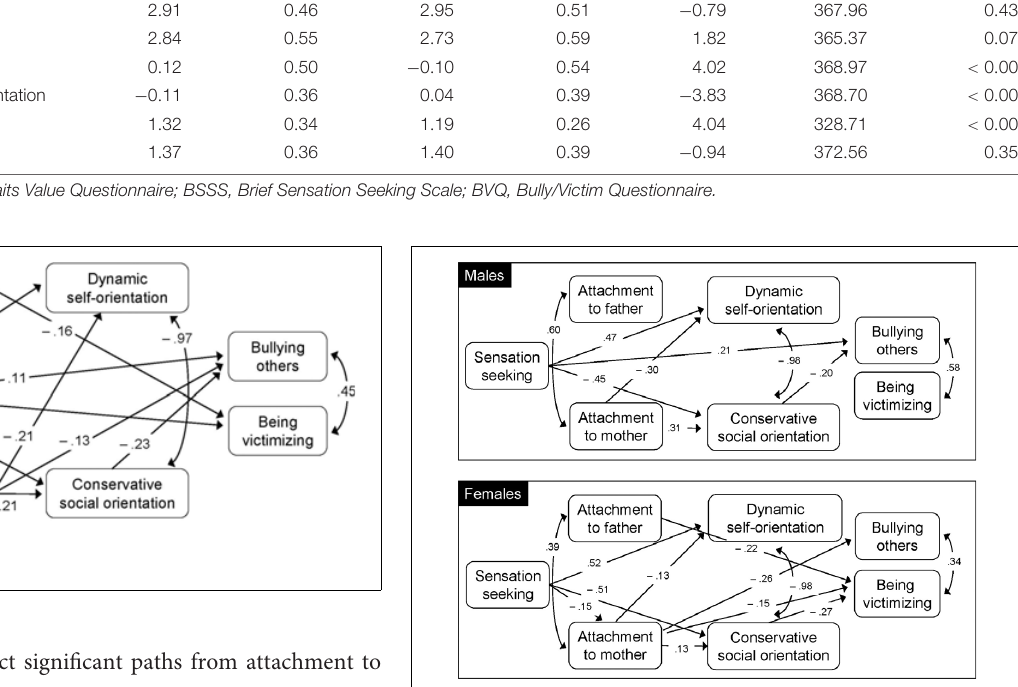
FIGURE 3 | Gender effect on attachment to mother’s role as a moderator between sensation seeking and bullying of